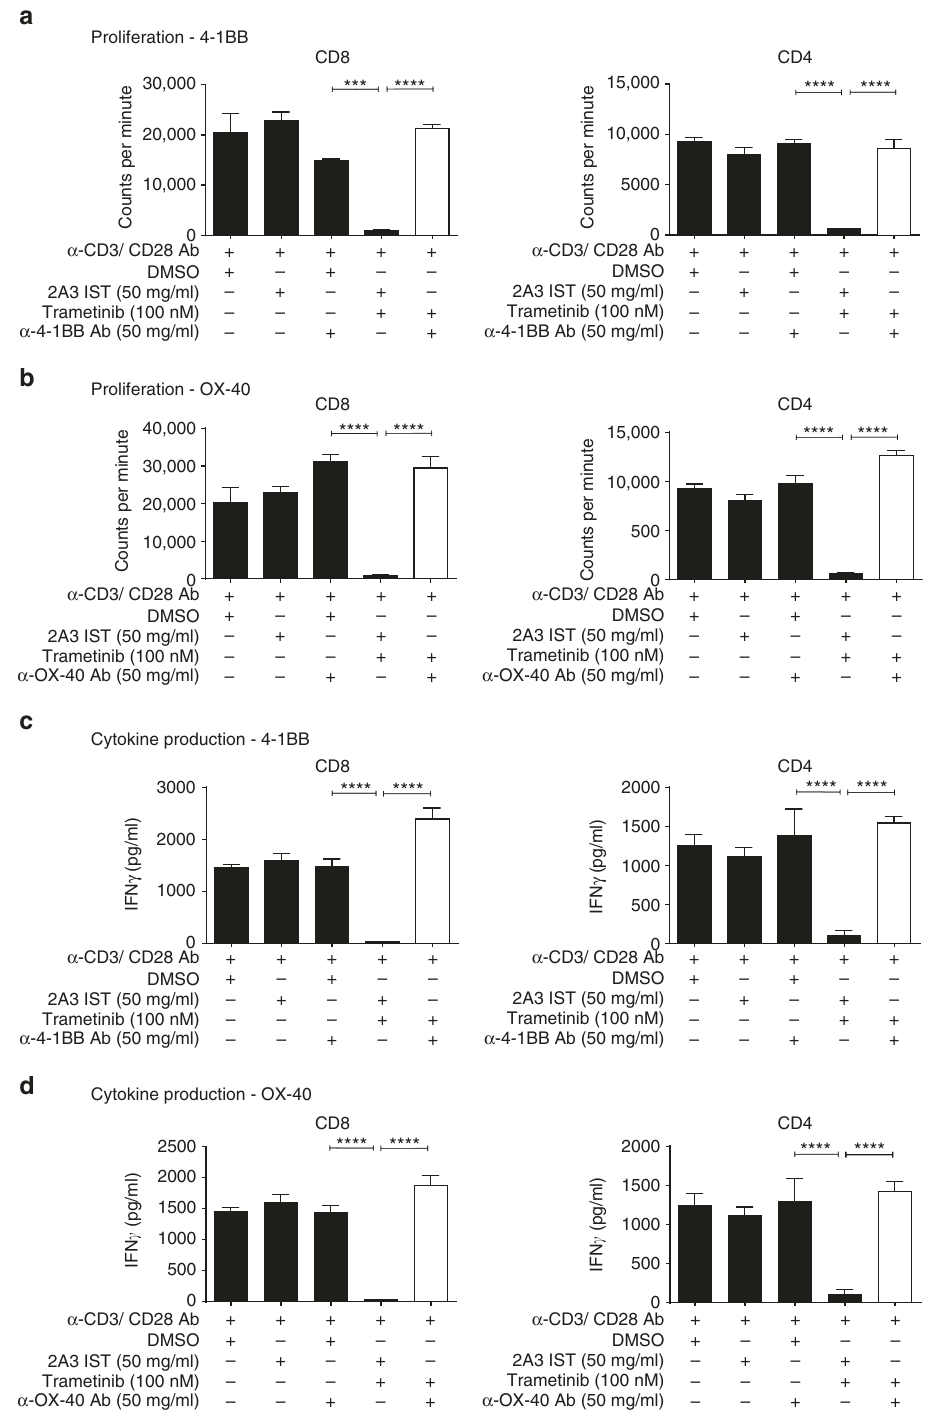
Fig. 4 Agonist immunotherapy treatment rescues inhibition of mouse T-cell function induced by MEK inhibition. Puri fi ed CD8 + or CD4 + murine T cells were stimulated with α -CD3 (1 µ g/ml) and α -CD28 (0.5 µ g/ml) antibodies and treated with vehicle (DMSO), 2A3 isotype, α -4-1BB or α -OX-40 antibody, trametinib alone, or combination of trametinib and agonist antibody. a , b Cell proliferation was measured by 3H-thymidine incorporation (added at 48 h) after 72 h of incubation with treatments. Proliferation in counts per minute (CPM) was measured for CD4 + and CD8 + T cells for a α -4-1BB antibody and b α -OX-40 antibody combinations. c , d IFN γ cytokine production (pg/ml) was measured from 72 h cultured supernatants via CBA analysis of c α -4-1BB antibody and d α -OX-40 antibody combinations in both CD8 + and CD4 + T cells, respectively. Experiments were performed in quadruplicate and is representative of 2 – 3 independent repeats. Controls groups are duplicated between panels as these experiments were performed concurrently. Data are presented as mean ± SEM. P -values represent one-way ANOVA and post hoc Fisher ’ s LSD tests. * P < 0.05, ** P < 0.01, *** P < 0.001, **** P <